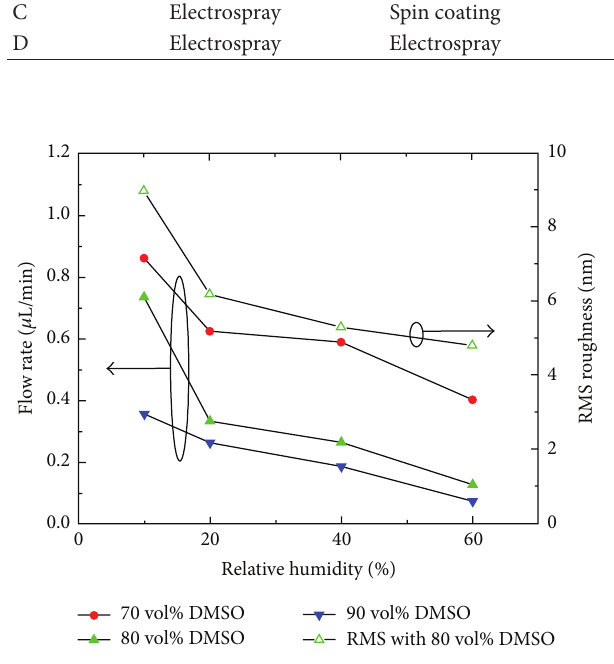
Figure 4: Flow rate of PEDOT:PSS inks coated at the relative humidity ranging from 10% to 60% and the RMS roughness of the PEDOT:PSS thin films coated from the PEDOT:PSS ink of 80 vol%